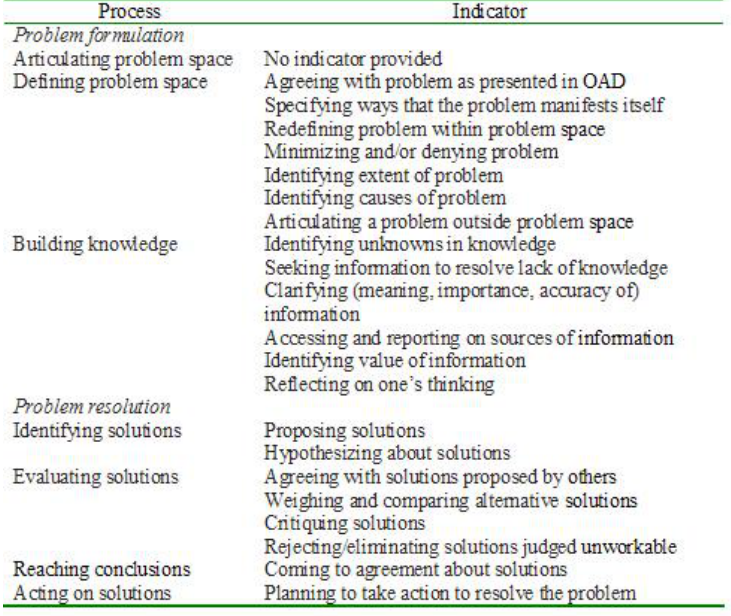
Table 1. Processes and Indicators for Identifying and Measuring PFR in